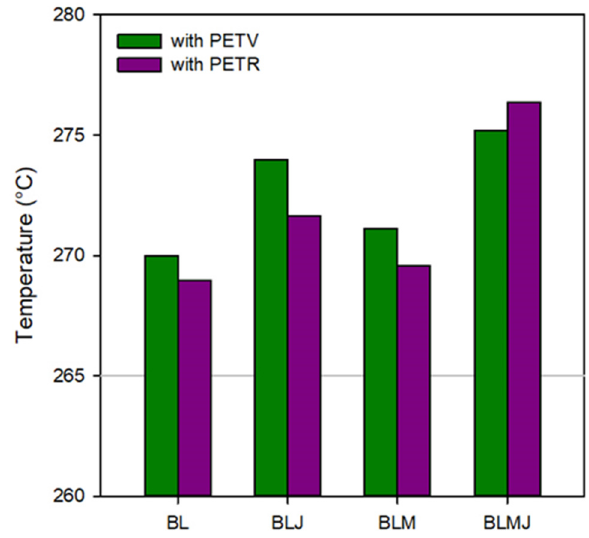
Figure 2. Average temperature in PETV/PEAD (1:1) and PETR/PEAD (1:1) blends at 12 to 15 min interval (BL = pure; BLJ = additivated; BLM = compatibilized; BLMJ = additivated and compatibilized).